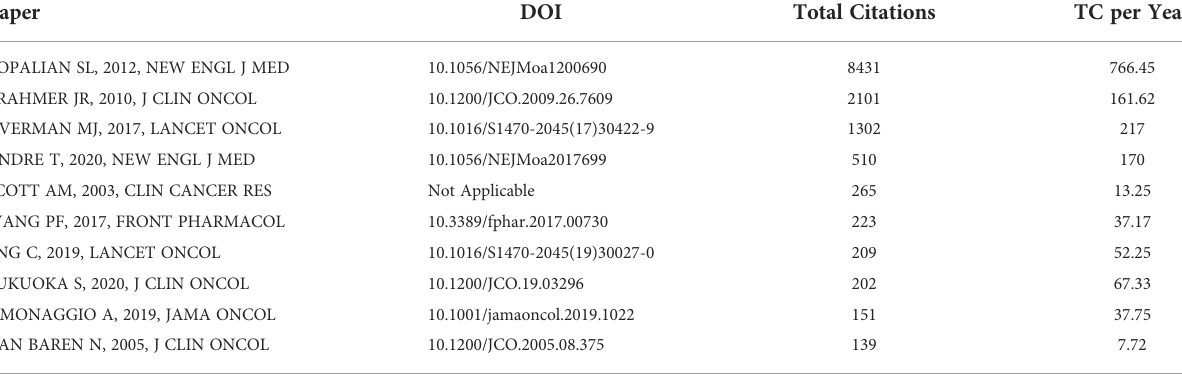
TABLE 2 Information of the 10 most cited documents.